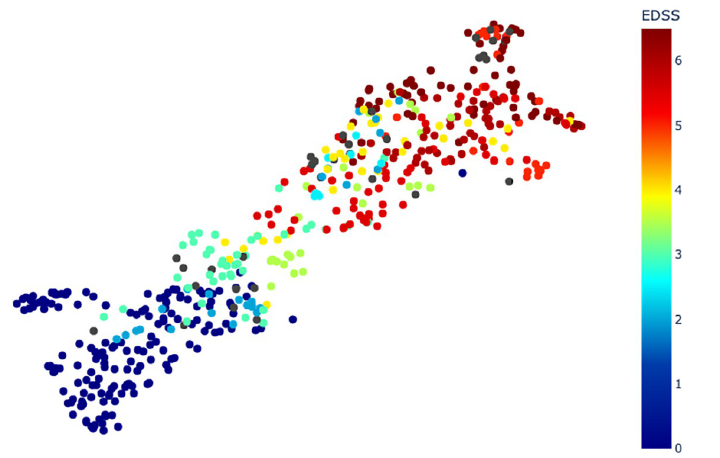
Fig 8. UMAP plot colored by